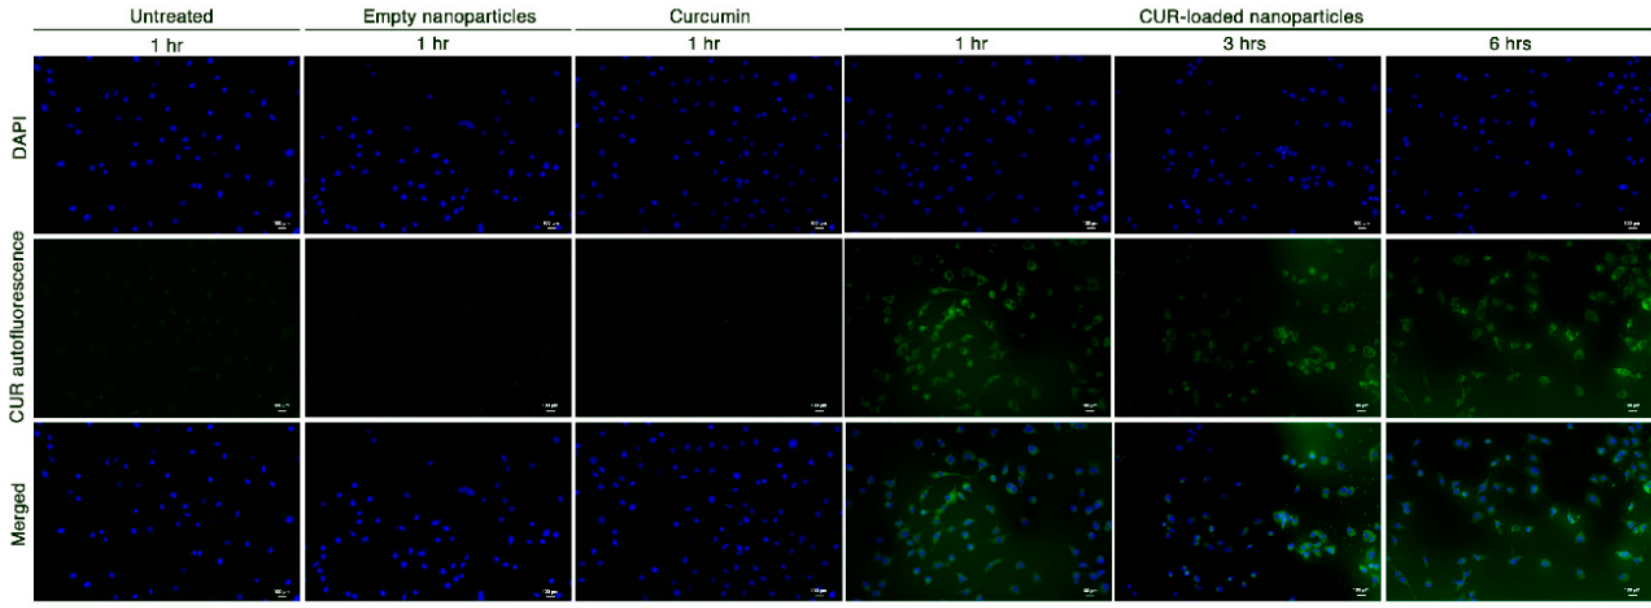
Figure 4. Curcumin green autofluorescence in STHdh 111/111 HD striatal-derived cells, before and after exposure to empty nanoparticles, 3.8 µM pure curcumin and 3.8 µM CUR-loaded nanoparticles at different time points (scale bar: 100 µm; 20× magnification).